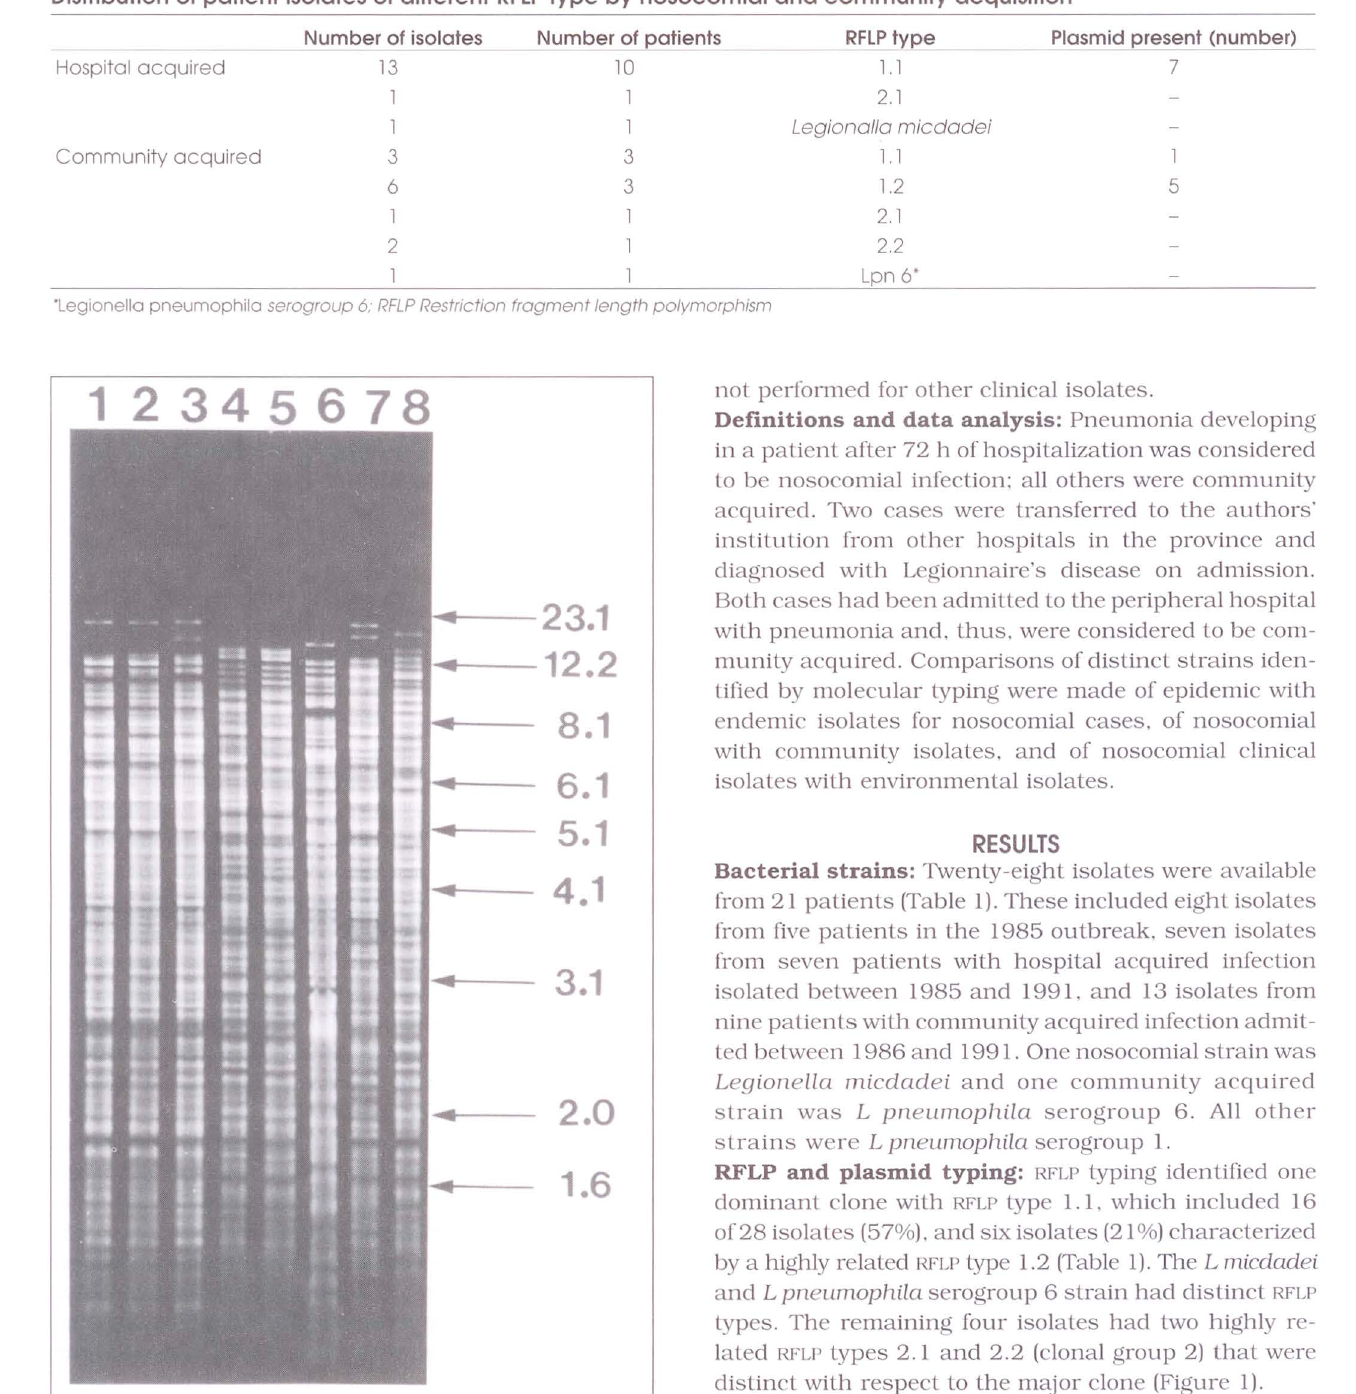
Distribution of patient isolates of different RFLP type by nosocomial and community acquisition Number of isolates Hospital acquired